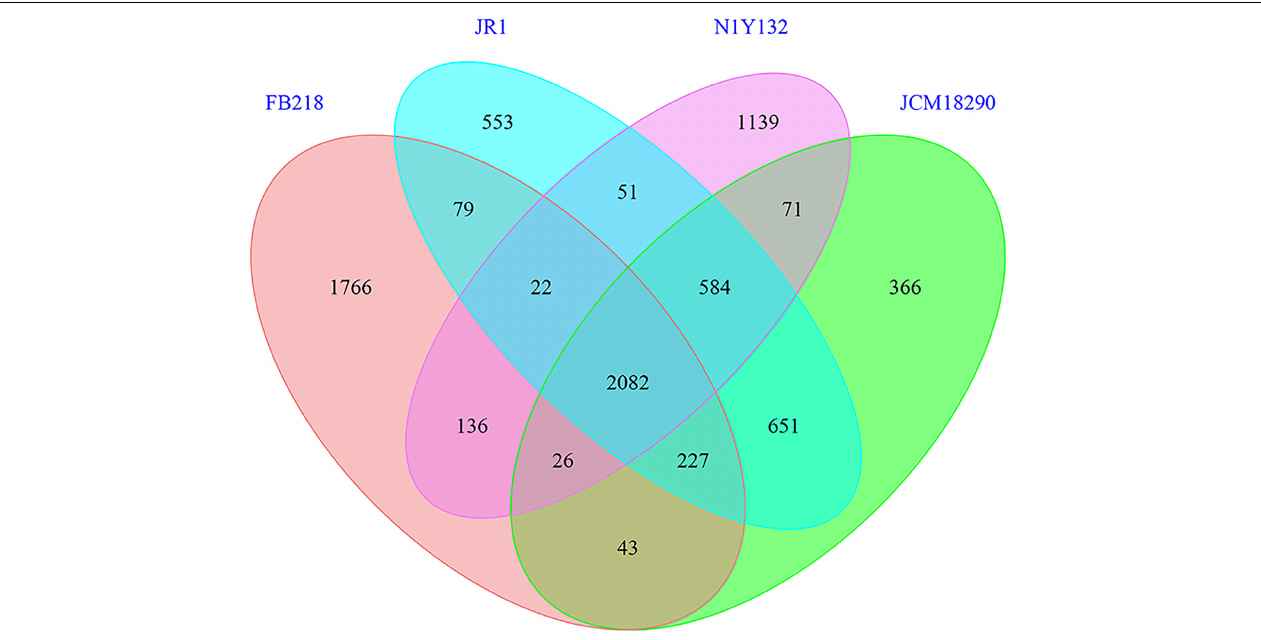
FIGURE 2 | Distribution of orthologous genes in the genomes of the four Carboxylicivirga species (strain N1Y132 T , C. mesophila JCM 18290 T , C. linearis FB218 T , and C. sediminis JR1 T ) tested by the CD-HIT rapid clustering of similar proteins software. 2082 core gene clusters that were represented in all four genomes.